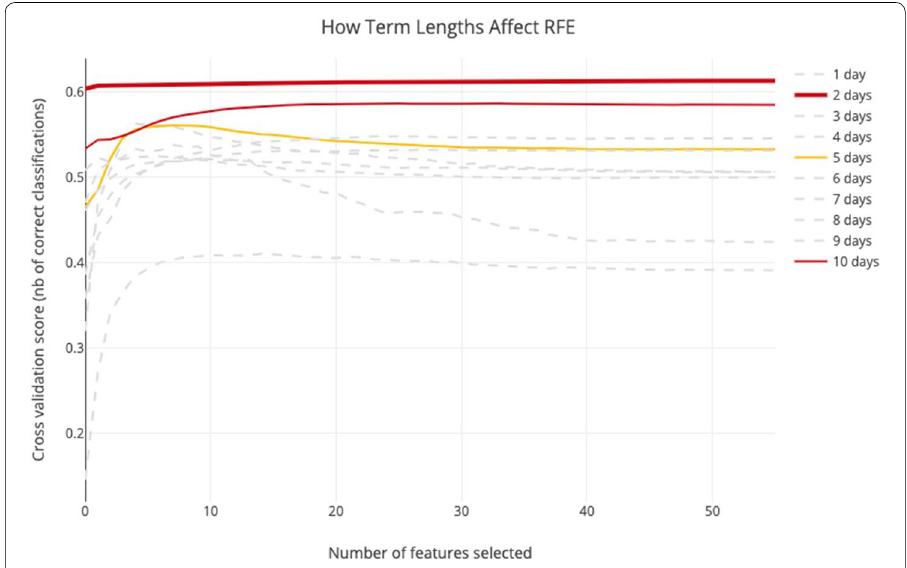
Fig. 4 How do term lengths affect the cross-validation score of